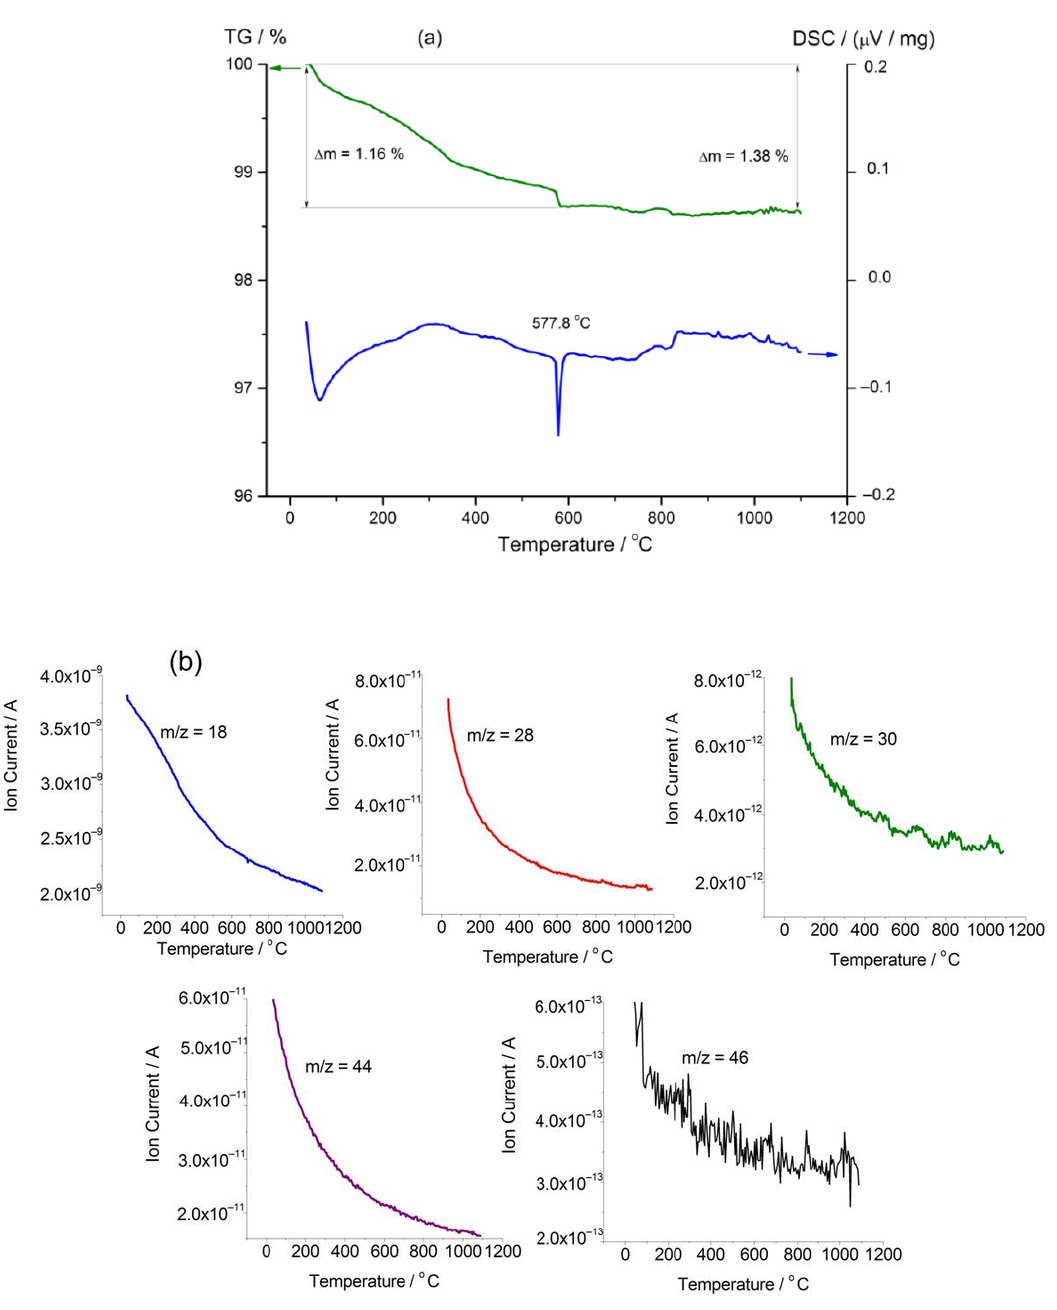
Figure 3. TG-DSC ( a ) and ion current data ( b ) for YSZ powder wetted with HNO 3 solution. Mass-to-charge ratios, m / z , correspond to H 2 O (18), CO (28), NO (30), CO 2 (44), and NO 2 (46).